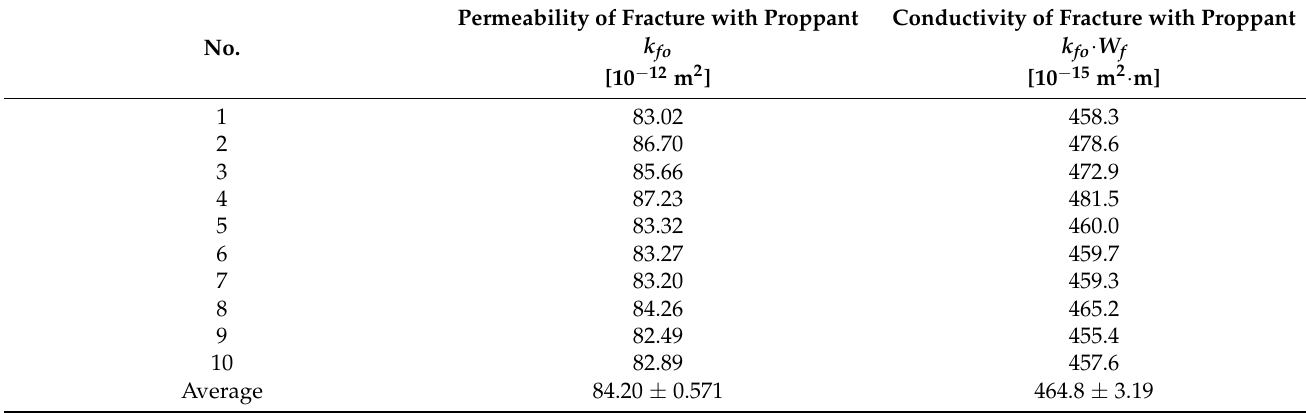
Table 9. The measurement results for the determination of the original conductivity and permeability of the fracture filled with light ceramic proppant 20/40, without damaging it with fluid, at 60 ◦ C; compressing stress 41.4 MPa.